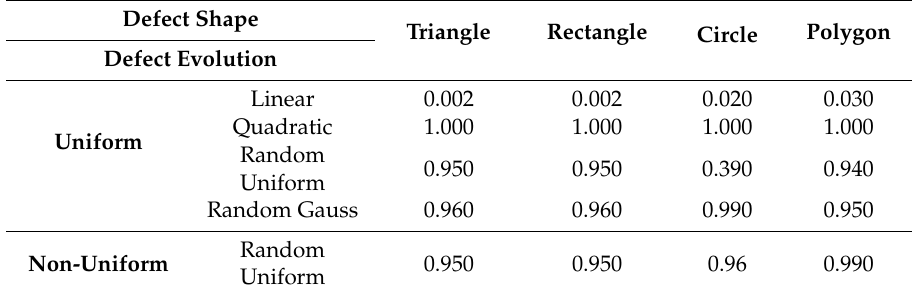
Table 1. The p -values from augmented Dickey–Fuller test stationary